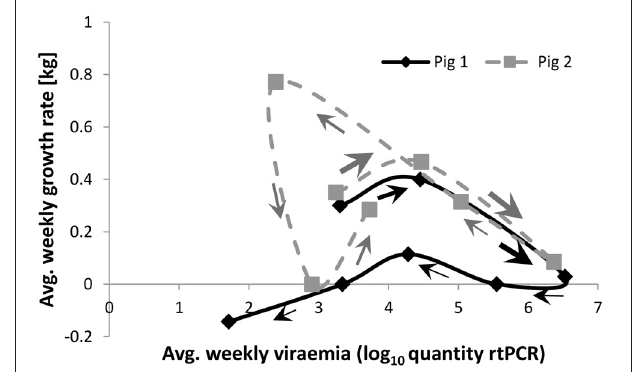
FIGURE 1 | Performance (average weekly growth rate) vs. pathogen burden (average weekly viraemia) trajectories for two individual pigs infected with the same challenge dose of a virulent PRRS virus strain. Arrows indicate the direction of growth rate-viraemia plots over time. The size of the arrows crudely reflect the speed at which the trajectory progresses. Data are courtesy of the PRRS Host Genetics Consortium—for more information about data acquisition and experimental design see Rowland et al. (2012).